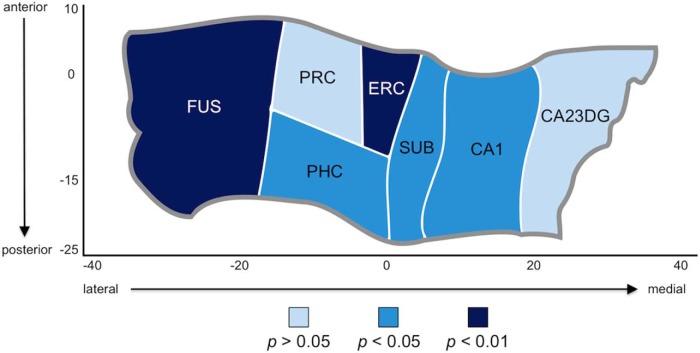
Hippocampal complex unfolded to reveal region-wise relationships to unweighted genetic risk score. A cortical unfolding procedure is used to produce a flat map of the hippocampal complex. Regions are colored according to the statistical strength of the association between unweighted risk score (URS) and the percentage change in thickness between baseline and follow-up scans. In addition to ERC, the fusiform (FUS) showed a significant relationship to URS at p < 0.01. Parahippocampal cortex (PHC), subiculum (SUB), and CA1 all showed a significant relationship to URS at p < 0.05. The only regions in the hippocampal complex where change in thickness was not associated to genetic risk were CA23 and dentate gyrus (CA23DG) and perirhinal cortex (PRC).